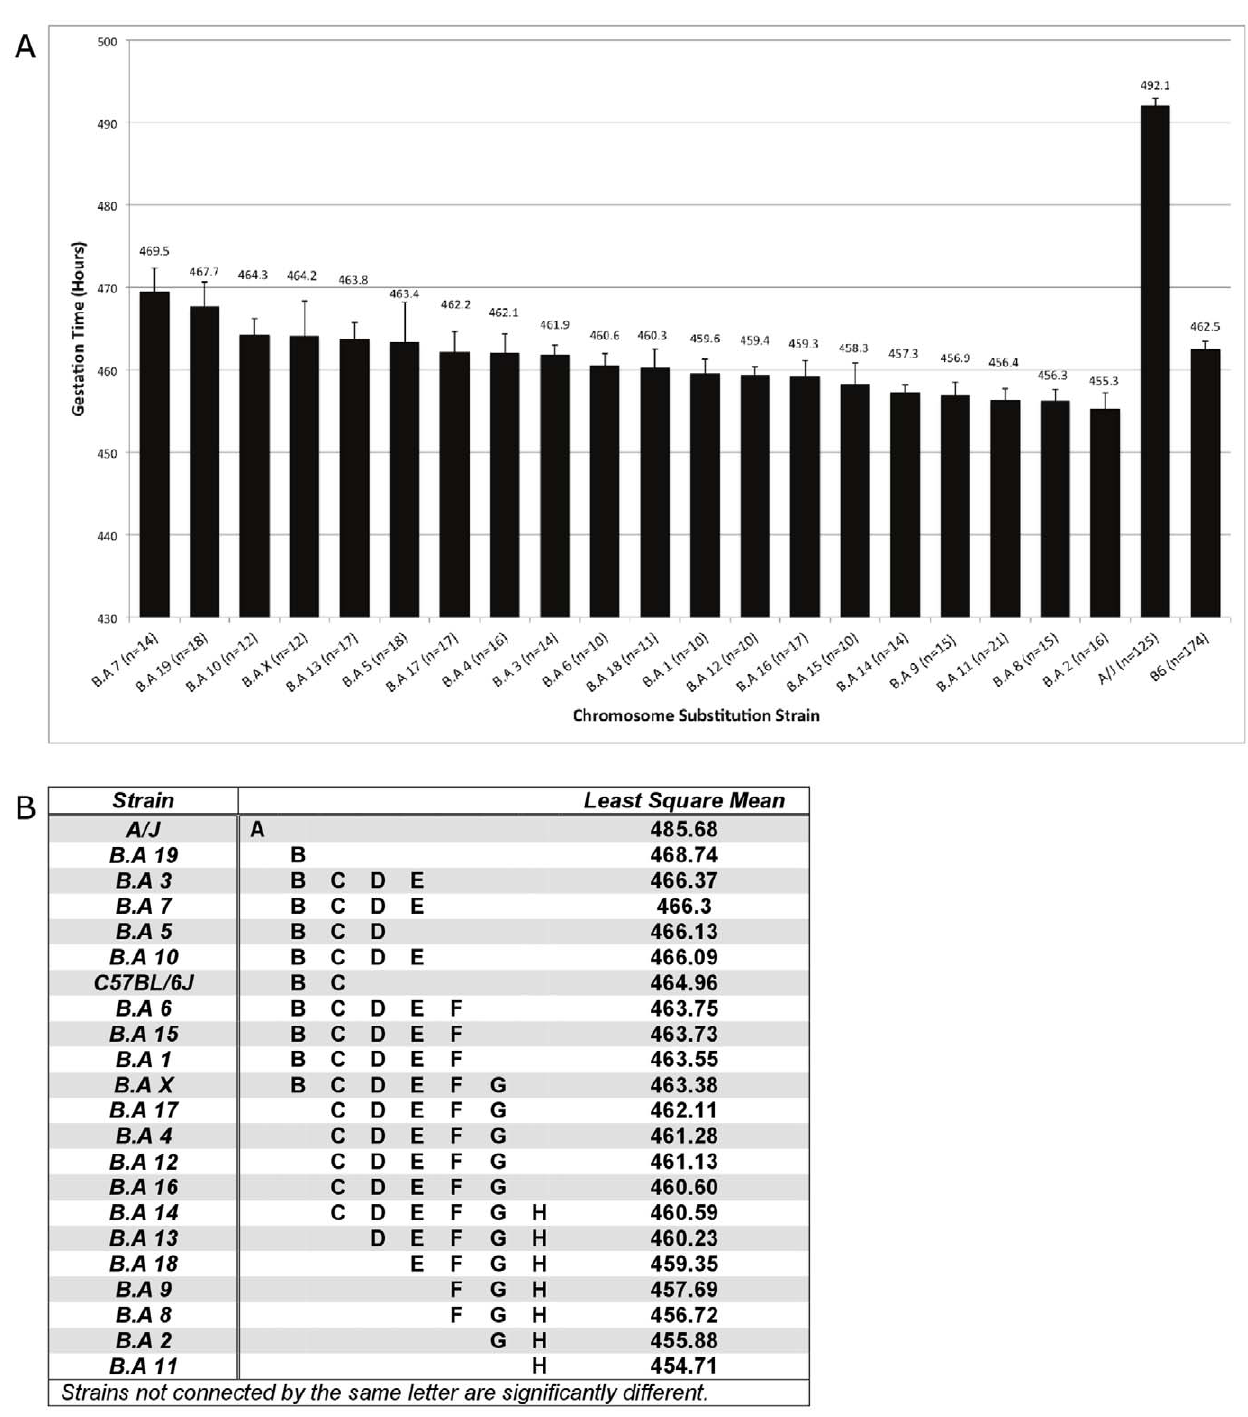
Figure 3. Complex, polygenic regulation of gestation length is revealed by the B.A CSS panel. (A) Mean gestation time in total hours for each of 20 CSS. The total number of pregnancies monitored is indicated for each strain and data are presented as the mean + / 2 S.E.M. (B) Graphical representation of individual CSS with significantly different GLs independent of all other factors. Strains that are not associated by a letter are significantly different from each other (p , 0.05).